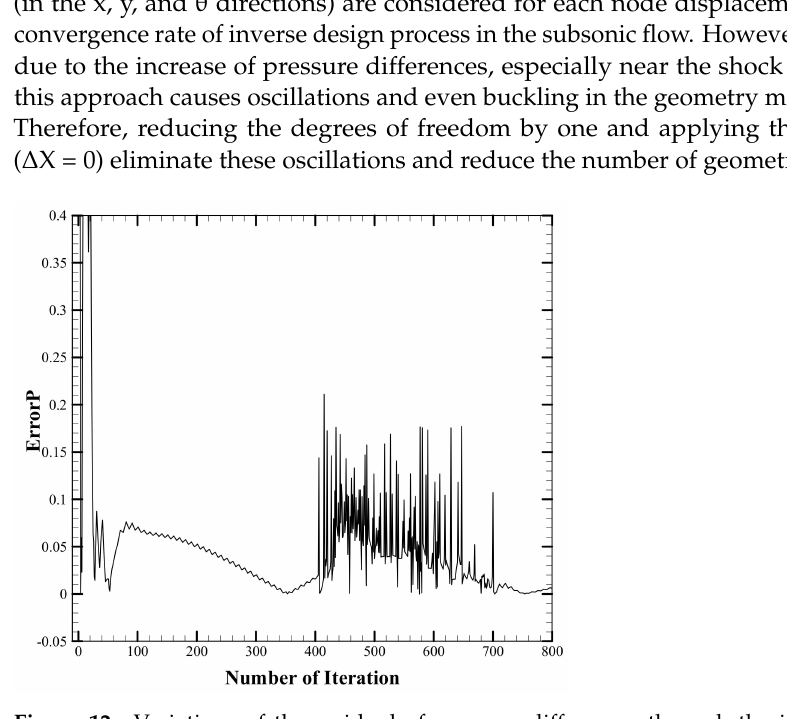
Figure 12. Variations of the residual of pressure differences through the iteration steps in the validation of UESA without spine